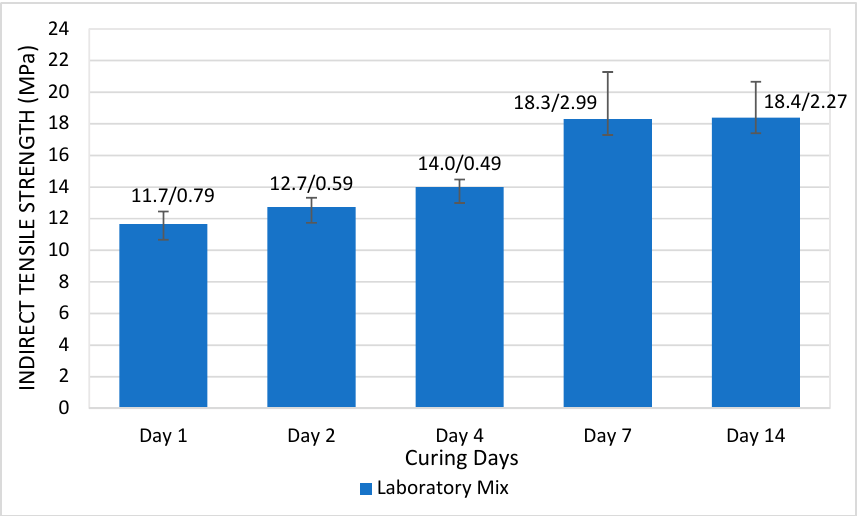
Figure 4. Averages and standard deviations of indirect tensile strengths of laboratory mixes.